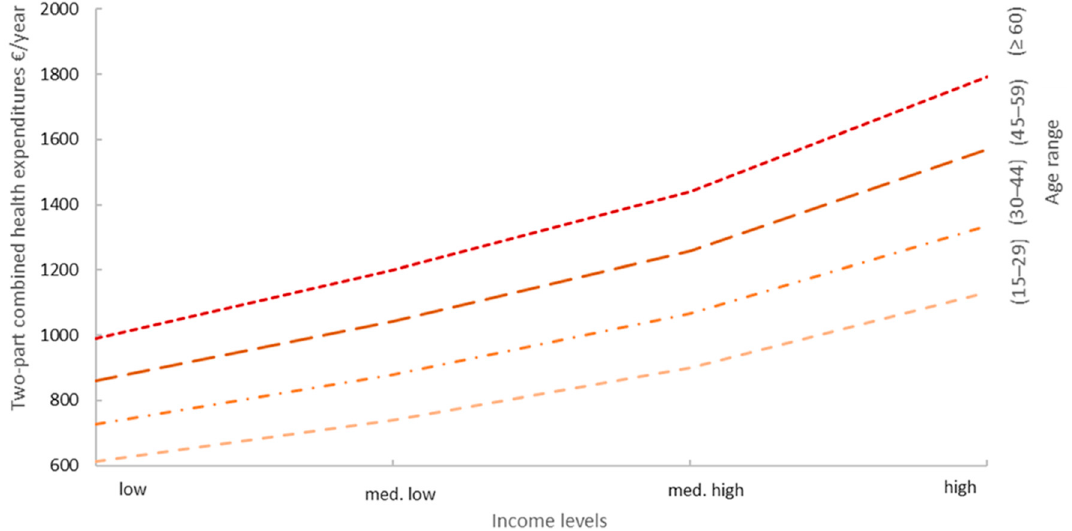
Figure 6. AAP for health expenditures by income level and age range.